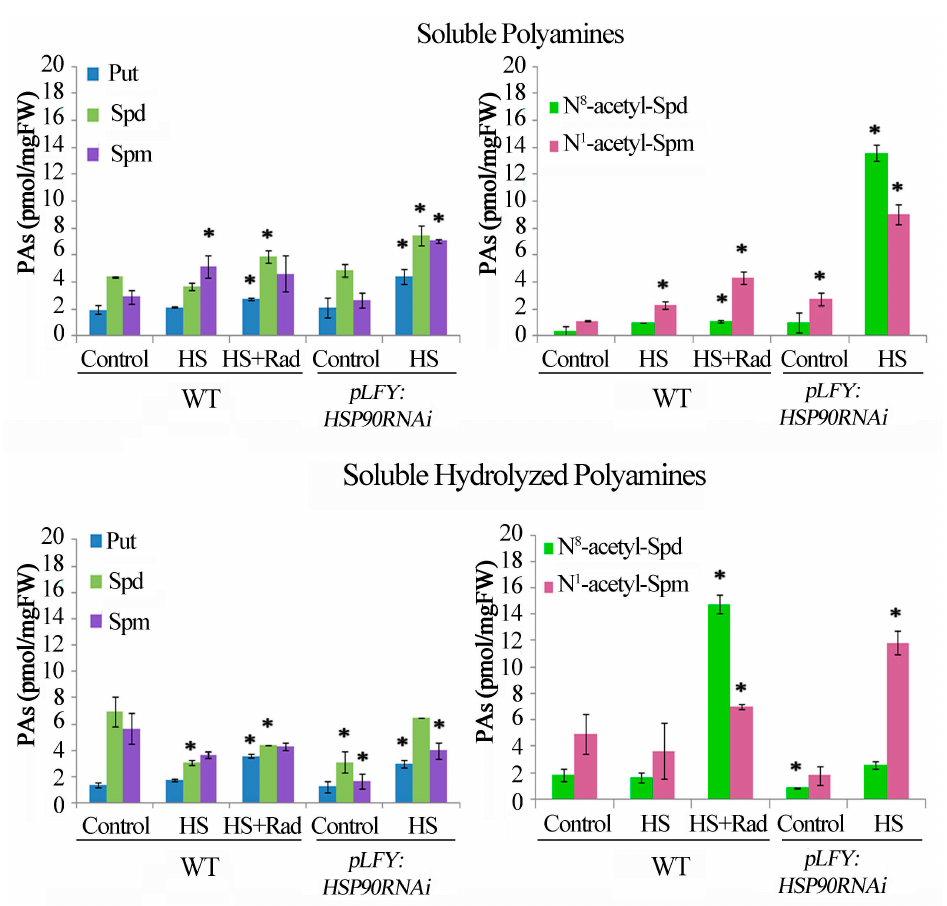
Figure 3. HSP90 activation/inhibition affects polyamine homeostasis in Arabidopsis thaliana